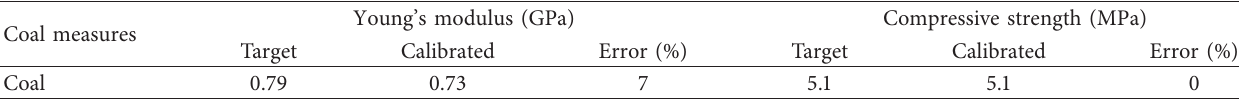
Table 3: Calibrated microproperties in the UDEC Trigon model to represent the coal.